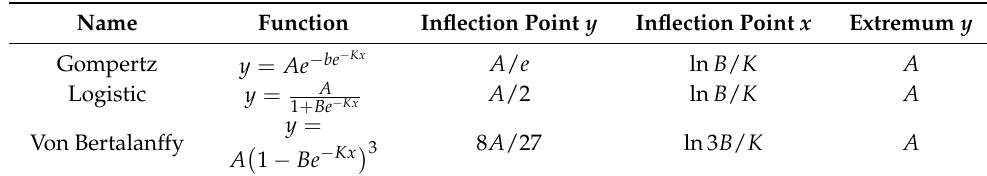
Figure 1. Network scale growth polylines for seven representative cities. Table 2. Common S-type curves.